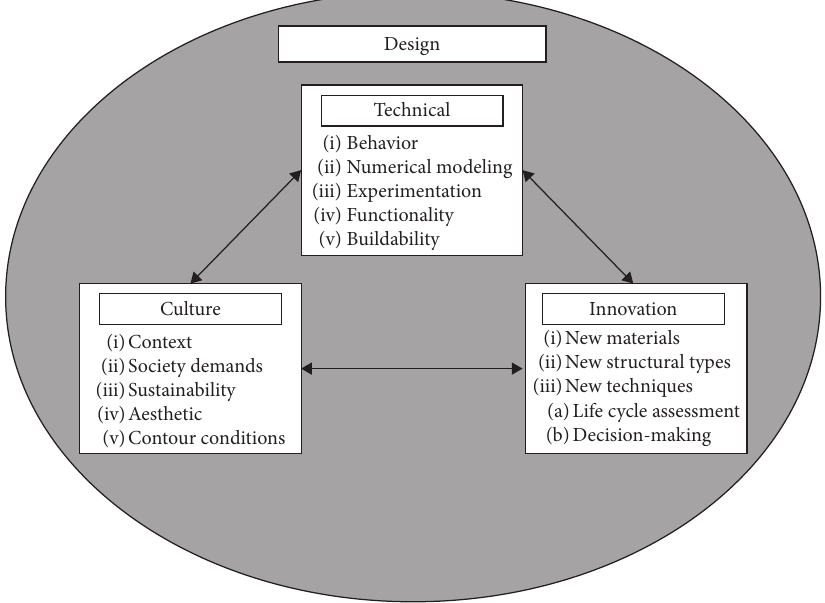
Figure 1: Scheme of design